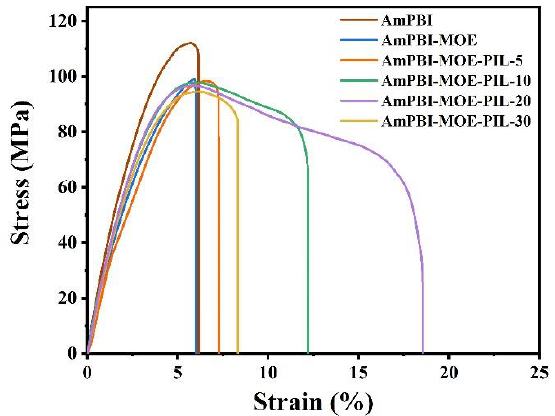
Figure 5. Mechanical properties of AmPBI, AmPBI-MOE-PIL-X membranes.